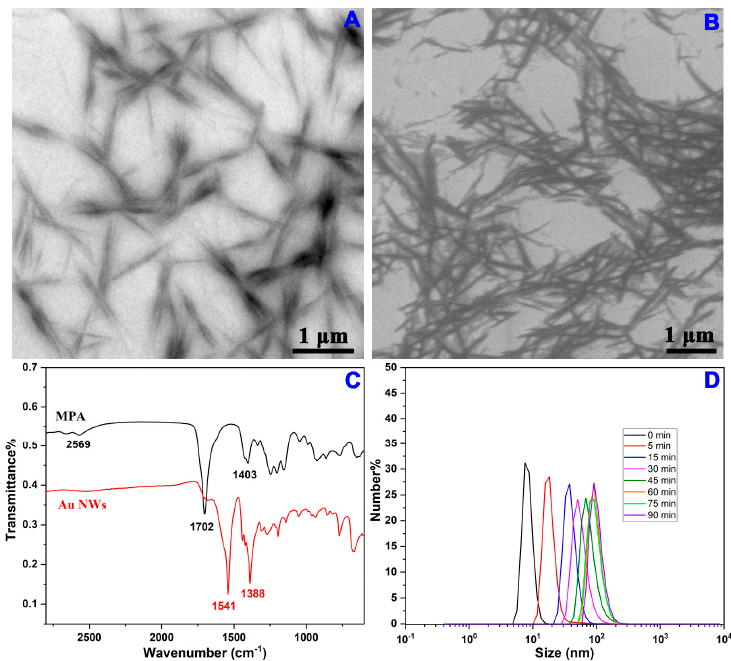
Figure 2. Characterization of the synthesized Au NWs. TEM ( A ) and SEM ( B ) image of Au NWs. FT-IR ( C ) of MPA and Au NWs. DLS ( D ) of Au NWs after introducing Zn 2+ ions 0–1.5 h.